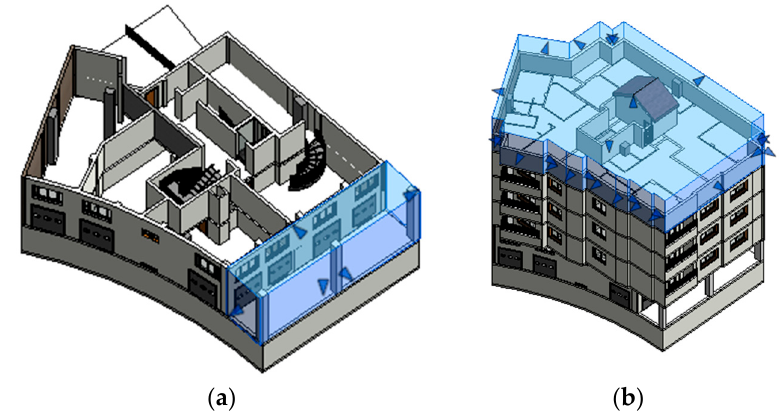
Figure 10. The 3D extent of: ( a ) the right-of-way easement; ( b ) the right of usage. The cadastral situation described above is represented by 2D plans relative to each floor, where data about vertical heights is represented by an elevation graphic of the building (Figure 11).